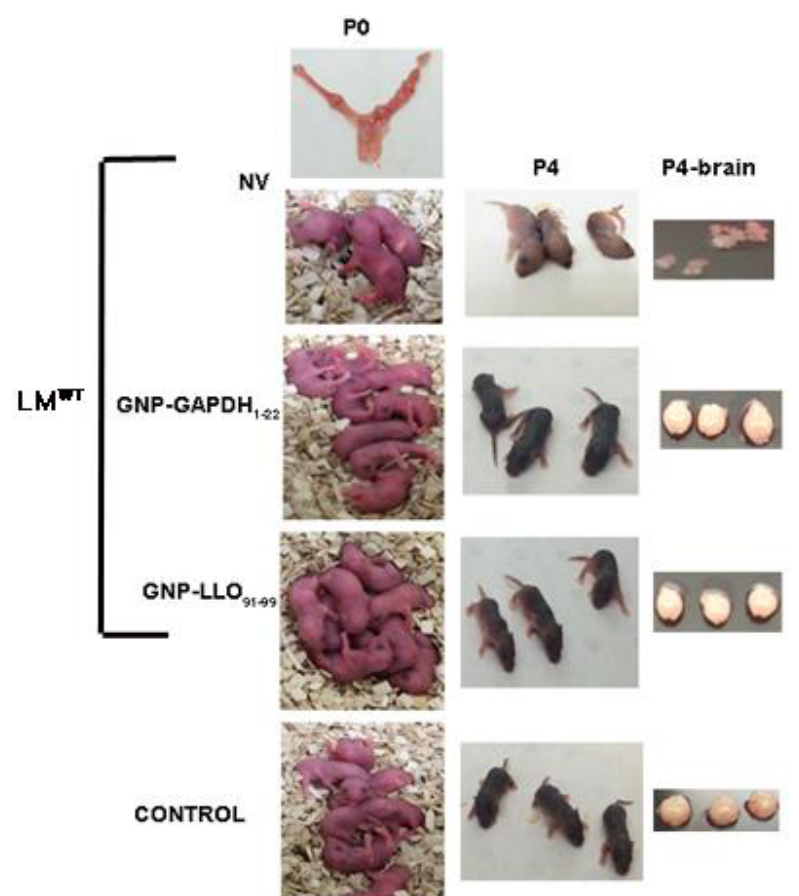
Figure 1. P0 corresponds to day 1 and P4 to day 4 of pups born to pregnant mothers. Groups of pregnant mothers were the following: non-vaccinated and challenged with Listeria monocytogenes (LM WT ) (NV), vaccinated and challenged with LM WT (gold glyconanoparticles listeriolysin peptide 91–99 (GNP-LLO 91–99 ) or gold glyconanoparticles glyceraldehyde-3-phosphate dehydrogenase 1–22 peptide (GNP-GAPDH 1–22 )) or non-vaccinated and non-infected with LM WT (control). P4-brain corresponds to brains of P4 neonates. Table 1. Clinical data of pups (P4) born to vaccinated, non-vaccinated (NV) or control mothers. Weight